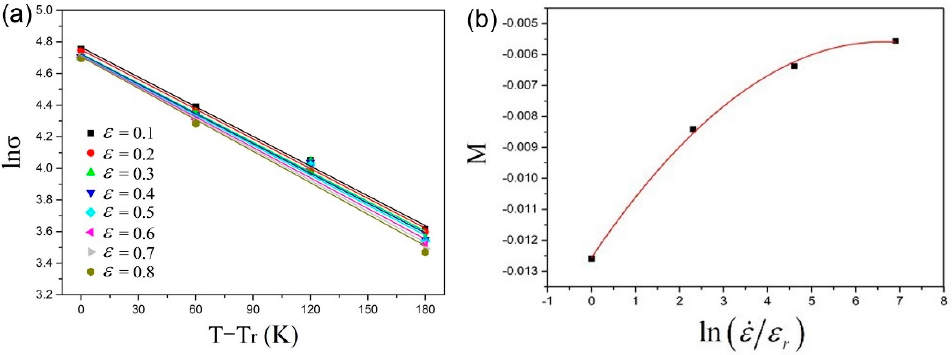
Figure 4. ( a ) The relationship between ( T − T r ) and ln σ ; ( b ) the relationship between ln and M . The values of c 1 , c 2 and c 3 can be determined by the values of M with strain rates of